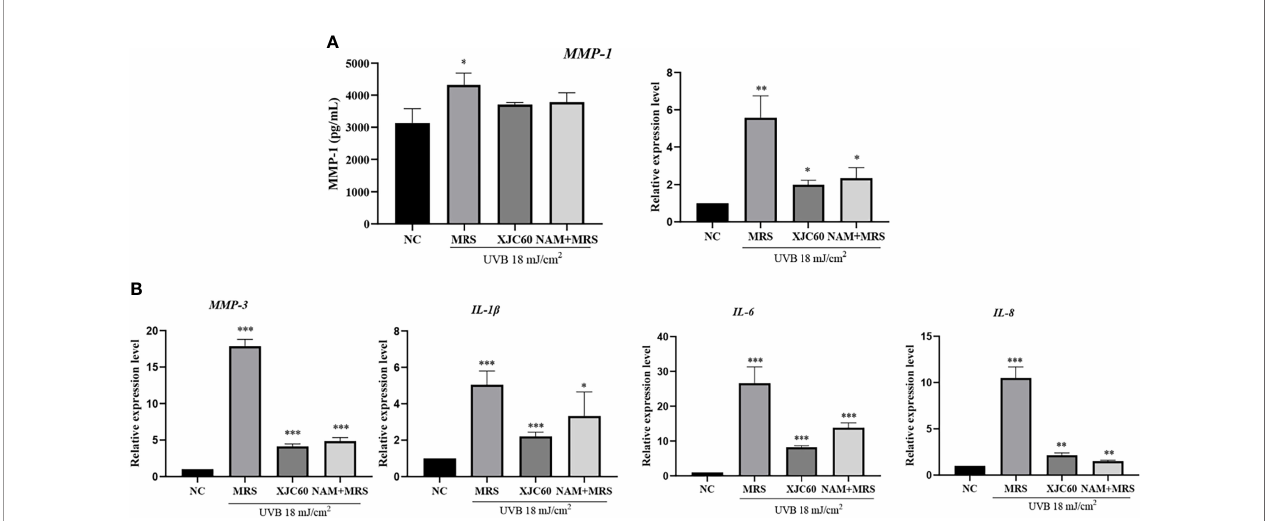
FIGURE 5 | Effects of Limosilactobacillus fermentum XJC60 and nicotinamide (NAM) on ECM and in fl ammation in UVB-injured HaCaT cells. (A) Evaluation of MMP- 1 protein and mRNA levels. (B) mRNA levels of other MMPs and in fl ammation-related factors. Relative mRNA levels of MMP-1 , MMP-3 , IL-1 b , IL-6 , and IL-8 in UVB- injured HaCaT cells were calculated using qPCR, with normalization to GAPDH expression. Data are presented as means ± SDs (n = 3). * P < 0.05, ** P < 0.01, *** P < 0.001 compared with the normal control (NC) group.